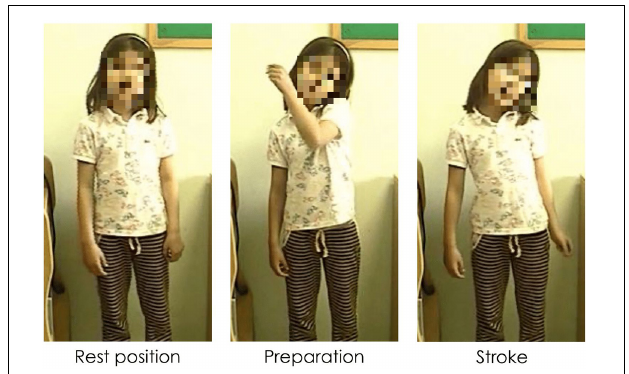
FIGURE 1 | Caption of an iconic gesture while saying “va DESFER la corda” (“[he] UNTIED the rope”). Capitalization indicates the word accompanied by a gesture.